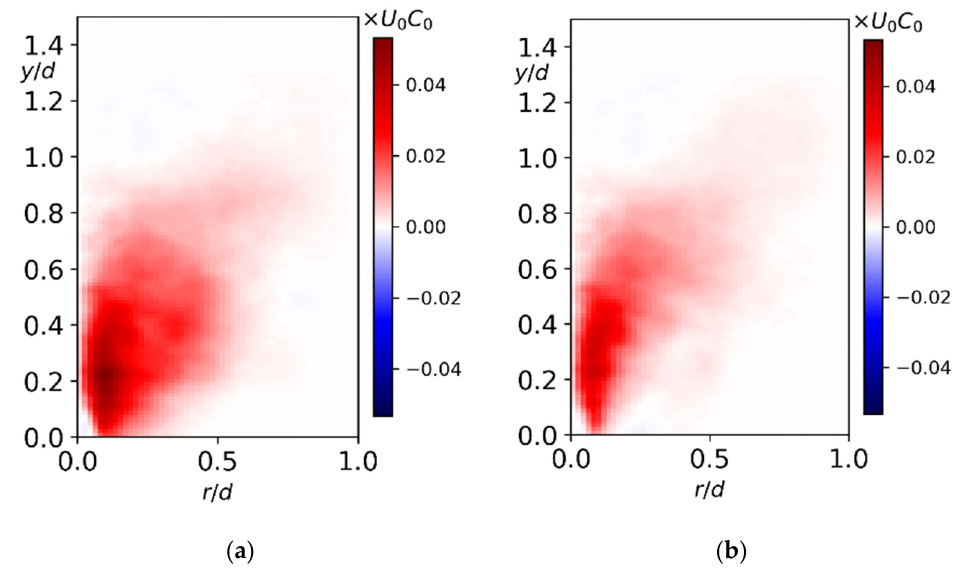
′ ′ ′ ′ , and the uu u u ′ ′ , ( b ) u u , ( c ) θ θ r r y y (cid:68) (cid:69) (cid:68) (cid:69) ′ ′ ′′ ′′ (cid:10) (cid:11) ′ ′ , and the uu ′′ ′′ for gas turbine swirler. uu u u ′ ′ , ( b ) u u , ( c ) u u ′′ ′′ , ( e ) u u u (cid:48) r u (cid:48) y u (cid:48) y u (cid:48) u (cid:48) r u (cid:48) , ( b ) , ( c ) , and the ( f ) θ θ r θ r y y θ r θ θ r y y (cid:10) (cid:11) (cid:10) (cid:11) (cid:10) (cid:11) ′′ ′′ u (cid:48)(cid:48) r u (cid:48)(cid:48) y u (cid:48)(cid:48) r u (cid:48)(cid:48) u (cid:48)(cid:48) y u (cid:48)(cid:48) , ( e ) ( f ) for gas turbine swirler. uu u u ′′ ′′ , ( e ) ( f ) for gas turbine swirler. θ θ θ r r y